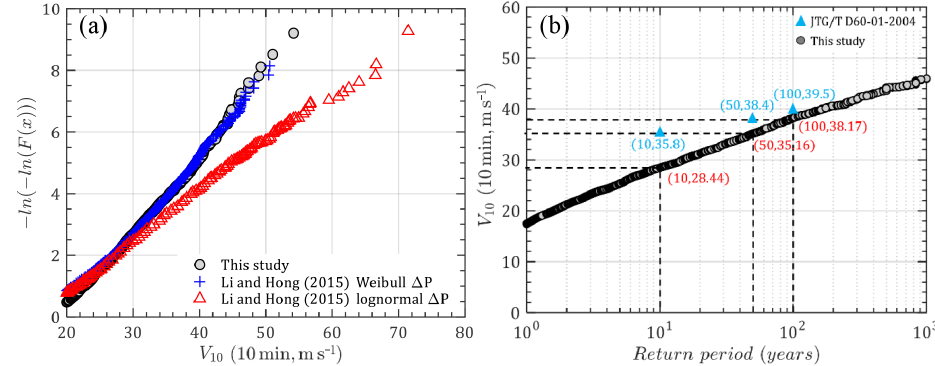
Figure 14. Design mean wind speed in Hong Kong: (a) empirical distribution; (b) mean wind speed versus return periods.